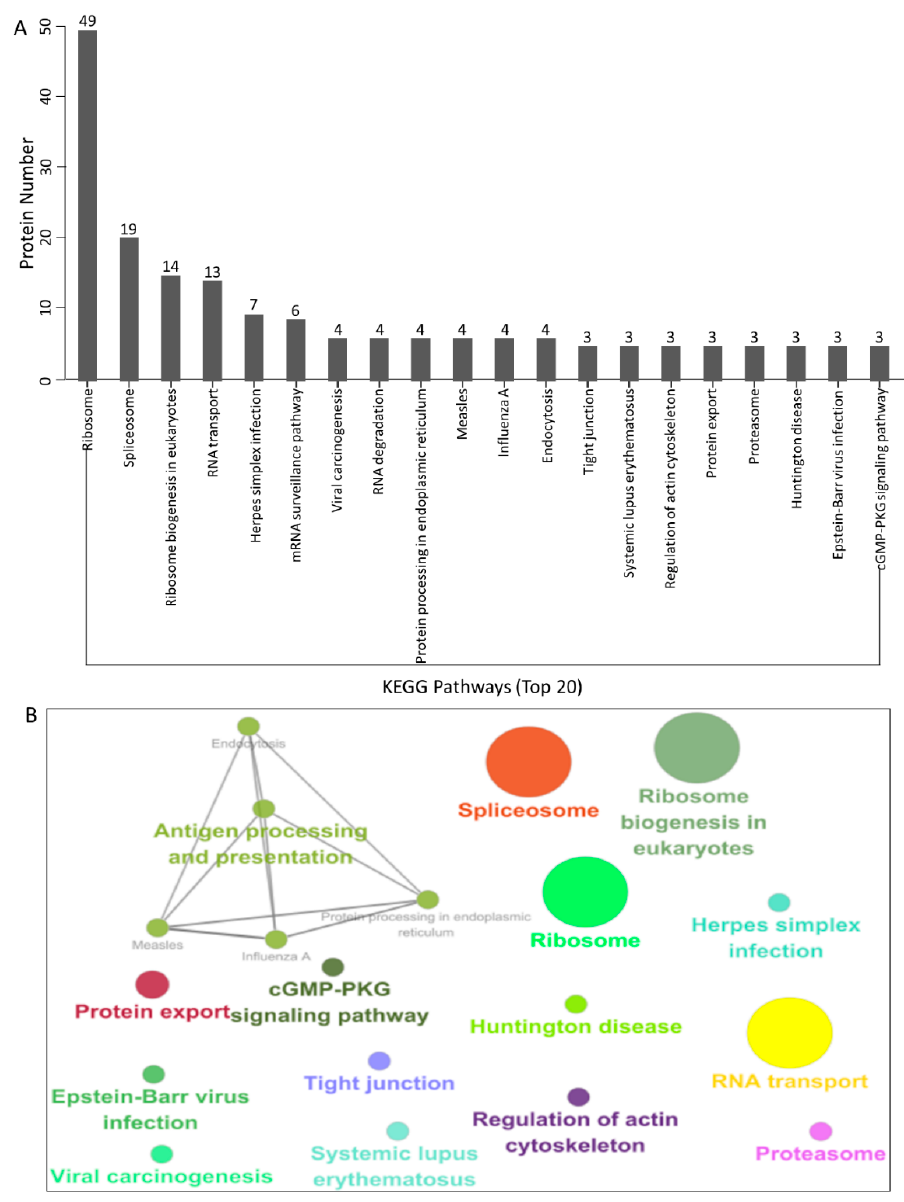
Figure 4. KEGG pathway enrichment analysis. ( A , B ) Graphs showing the enriched pathways targeted by the PCV3 and PCV4 Cap-interacting proteins, as analyzed via KEGG functional annotation (Supplementary Table S5) using the GOclue plugin in Cytoscape software, version 3.7.1. 3.5. Validation of the Interactions between Host Proteins and PCV3 or PCV4 Capsid Proteins To further verify protein interactions from mass spectrometry, we performed in vitro Co-IP assays. Eight host proteins from PCV3 or PCV4 Cap-transfected samples were ran- domly selected to validate mass spectrometry data. HEK293T cells were co-transfected with Myc-PCV3-Cap or Myc-PCV4-Cap and empty vectors; FLAG-NPM1, NCL, DDX21, hnRNPA2/B1, YTHDF1, YBX1, RNF2, or STAT6 expression constructs; and then subjected to immunoprecipitation with FLAG beads or anti-Myc purified monoclonal antibody (mAb). The results indicated that PCV3 or PCV4 Cap bound specifically to NPM1, NCL, DDX21, hnRNPA2/B1, YTHDF1, and YBX1, while no signal was observed with the empty vector, RNF2, and STAT6 constructs, although they exhibited distinct binding capacities